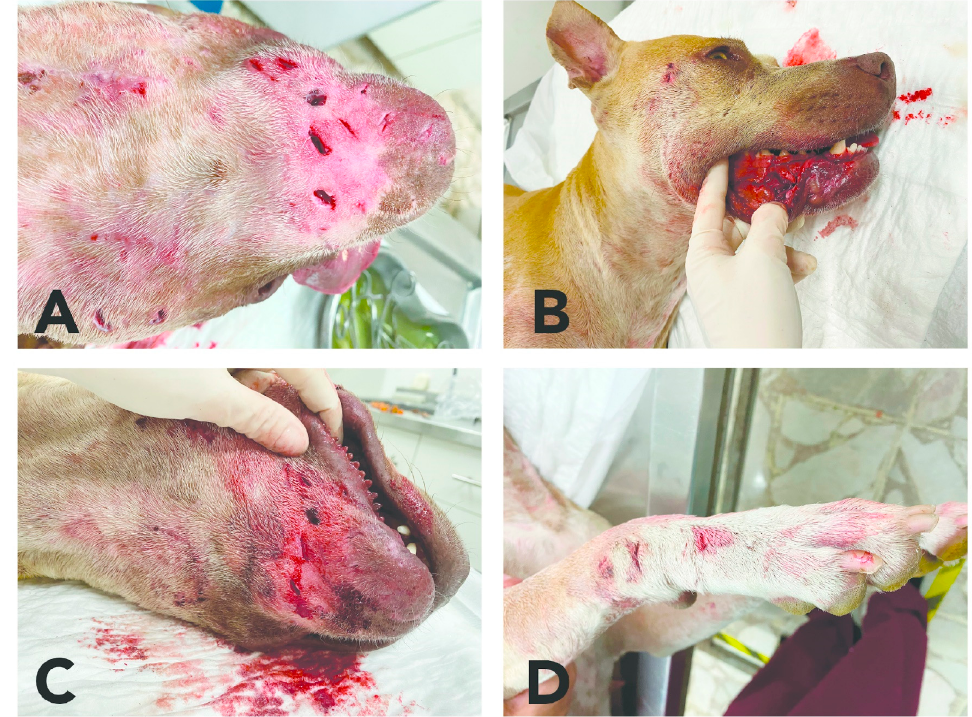
Figure 3. Lesions caused during a fight between two Pit Bulls (one male, one female). The female suffered the deepest wounds, shown in image ( A , C ). Obvious orifices in the skin of the mandibular region due to penetrating injuries inflicted by the other dog’s teeth ( B ). Lesions in the oral cavity, specifically the lower gum and lip ( D ). Deep lesions in the right thoracic limb that resulted from bites by the other dog. Most of these lesions required thorough washing and suturing to join the edges of the bites and prescriptions for antibiotics and analgesics.